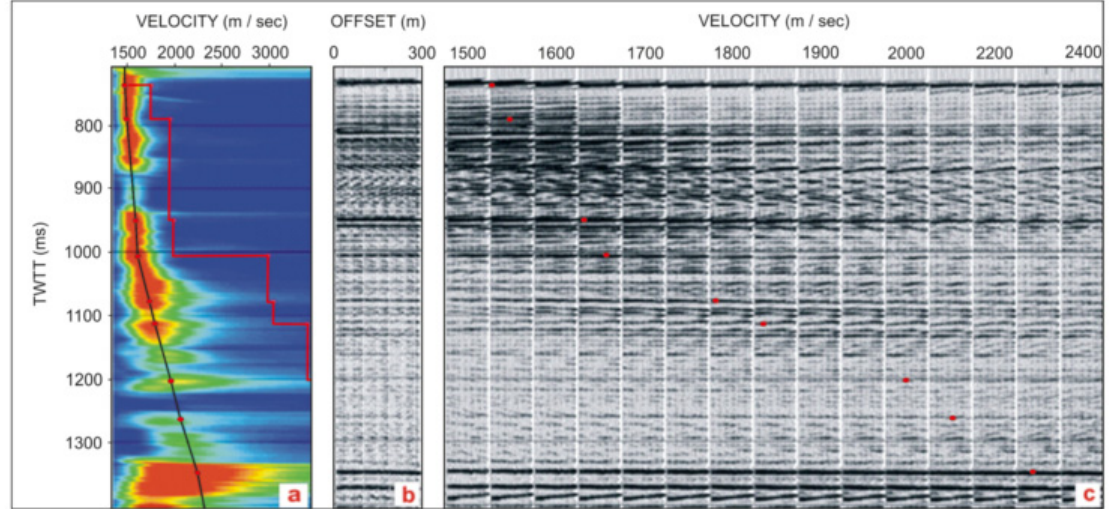
Figure 11. An example of velocity analysis on a CMP of the T_T09_HR profile. In the semblance (a), the RMS velocity function is repre- sented by the solid black line joining the velocity peaks; the corresponding interval velocity function is represented by the solid red line; (b) supergather; (c) constant velocity stack (CVS) panels. Each red dot on the CVSs represents the correspondent velocity pick in the semblance (see text for further